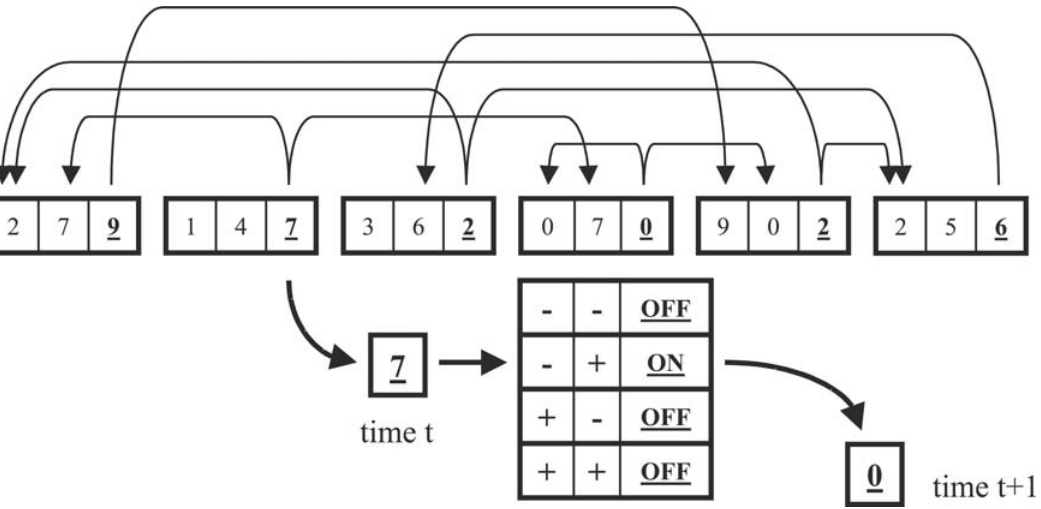
Figure 1. Schematic diagram of the network model. Shown are six genes, each with a regulatory region of length 2 and a coding region (underlined). Arrows represent possible interactions, i.e. directed edges in the network. Below one gene is the Boolean rule set specific to that gene. A ‘‘ 2 ‘‘ indicates that the binding site is not bound by the corresponding product, and a ‘‘ + ’’ indicates that it is bound. The gene is then either expressed (‘‘on’’) or not (‘‘off’’). In this case, if product 7 but not product 0 is present at time t , the binding state of the regulatory region of this gene corresponds to the second row of the Boolean table. As a result, the gene is expressed and product 0 is present at time t + 1. Because 0 occurs in both the regulatory region and the coding region of this gene, it is self-regulating and will not be expressed at time t + 2.